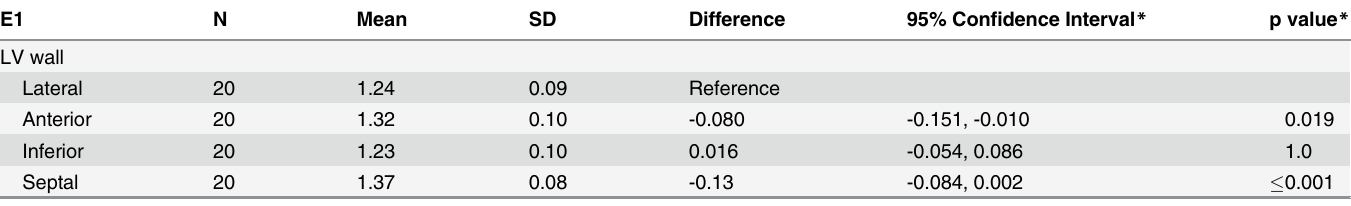
Table 2. Mean Diffusivity Regional Analysis (×10 -3 mm 2 s -1 ) Lateral wall used as the reference for statistical comparisons. The average global myocardial SNR measured in the reference images was 13.2 ±2.2. The SNR was greater in the mesocardium (14.5 ±2.5) than the endocardium (13.0 ±2.2, p < 0.001), and epicardium (12.0 ±2.4, p < 0.001, Fig 5). The results for regional wall analysis are included in table 6. With the lateral wall (11.5 ± 1.5) as the reference, the SNR was greater in the septum (16.1 ± 3.4, p < 0.001) and anterior wall (14.0 ± 3.1, p < 0.001). Comparative HA, MD, FA & SNR maps for both standard resolution and high resolution scans for 2 volunteers are shown in Fig 7. In both cases, the SNR maps show lower transmural SNR in the higher resolution images (global SNR 11.5 vs 15.4 in subject 1 and 8.5 vs 14.8 in subject sequence (0.82 vs 0.88 and 0.88 vs 0.93 in the two subjects) and an increase in FA (0.55 vs 0.48 and 0.51 vs 0.46). In both cases the relative increase in mesocardial FA is present at both resolu- tions. In regions of poor SNR, the FA is elevated.